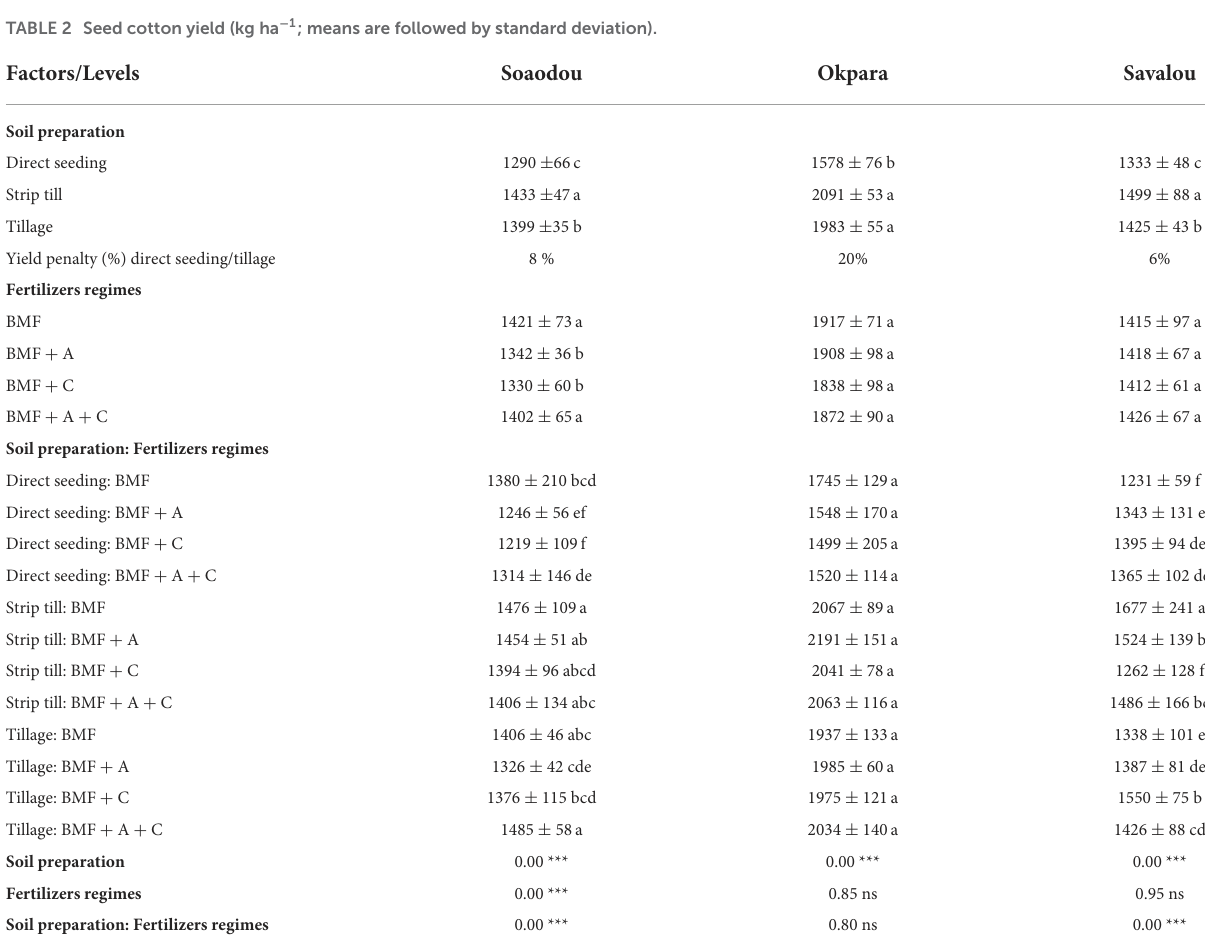
TABLE 2 Seed cotton yield (kg ha − 1 ; means are followed by standard